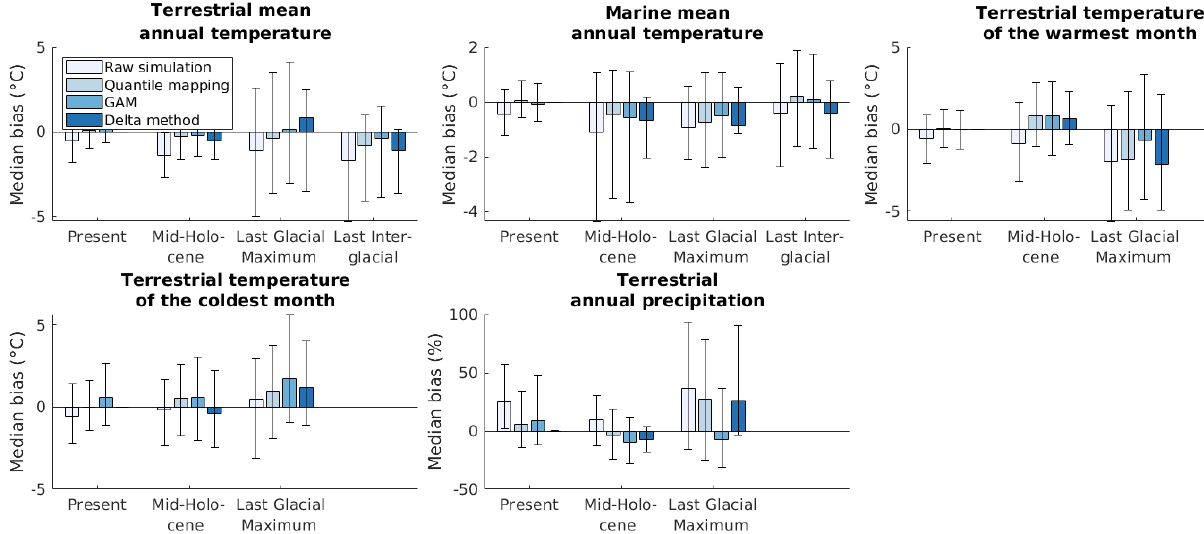
Figure A2. Median biases (MB in Eq. 8) of the raw and bias-corrected climate simulation data. Error bars represent 25% and 75% weighted quantiles of the local biases available for the given climate variable and point in